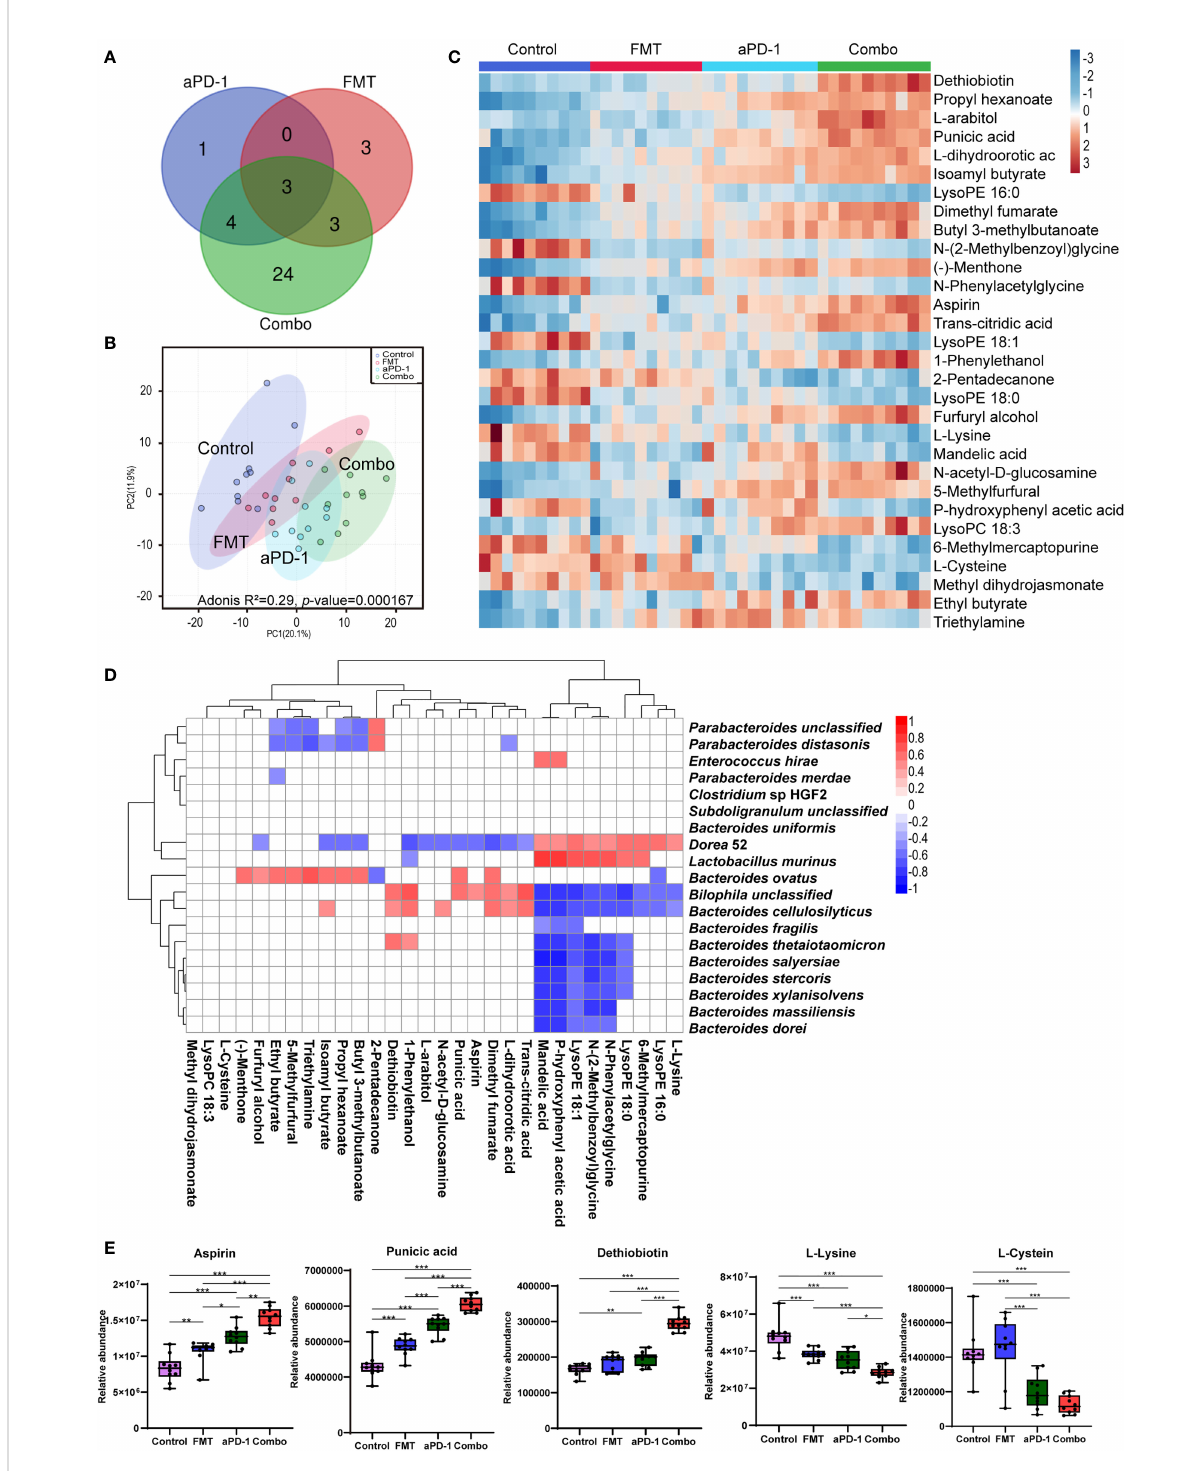
FIGURE 4 FMT altered plasma metabolites in CT-26 tumor-bearing mice receiving anti-PD-1 therapy. (A) Venn diagrams showing number of signi fi cantly changed metabolites in each group after treatment. (B) PCA plot of metabolomic results. (C) Heatmap of differentially abundant metabolites using one-way analysis of variance. (D) The correlations between metabolites and microorganism. (E) Abundance of speci fi c metabolites in different groups. Data are represented as mean ± SD. *, p -value < 0.05; **, p -value < 0.01; ***, p -value <